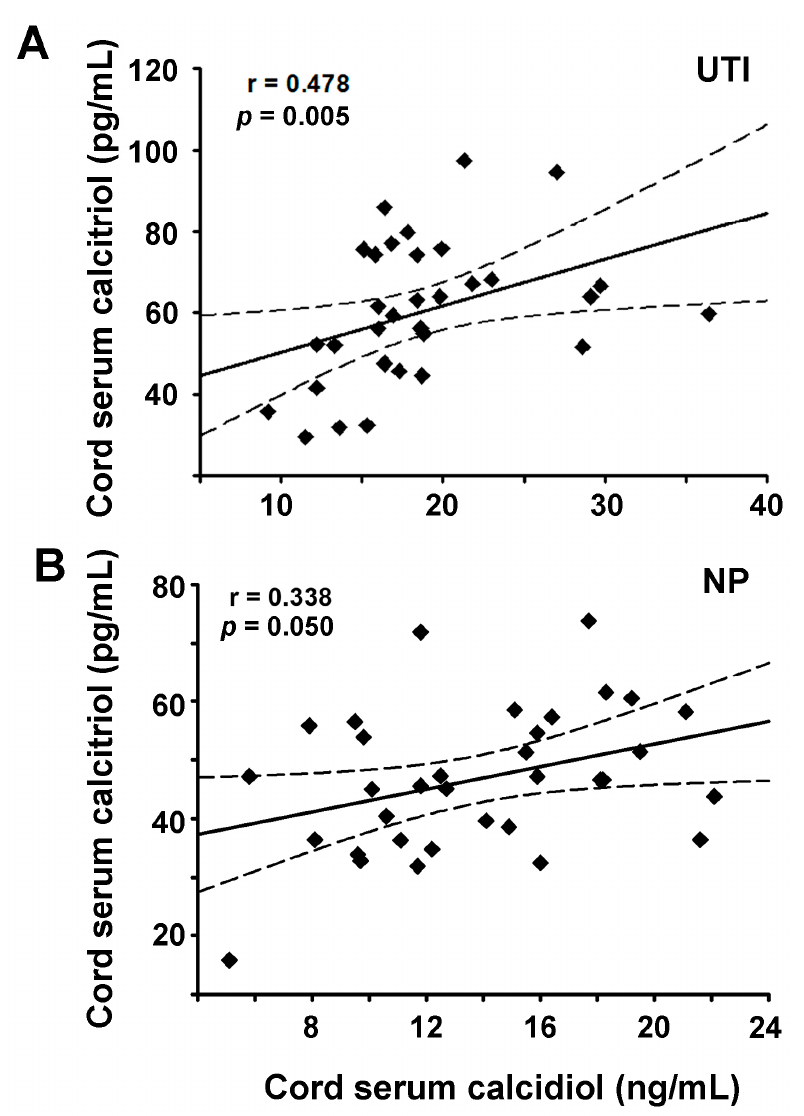
Figure 4. Positive correlation between cord serum levels of calcitriol and calcidiol. Simple linear regression plots depict positive correlations between calcitriol and calcidiol in cord serum samples from the cohort of urinary tract infection (UTI, A ) and normal pregnancy (NP, B ). Dashed lines indicate 95% confidence intervals.